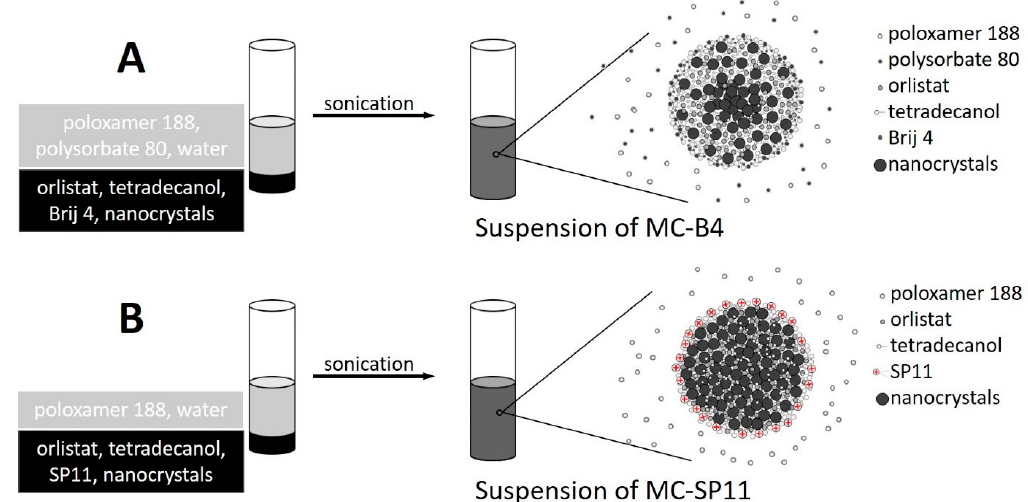
Figure 2. Schematic representation of the MC-B4 ( A ) and MC-SP11 ( B ) magnetic nanocarriers preparation method.